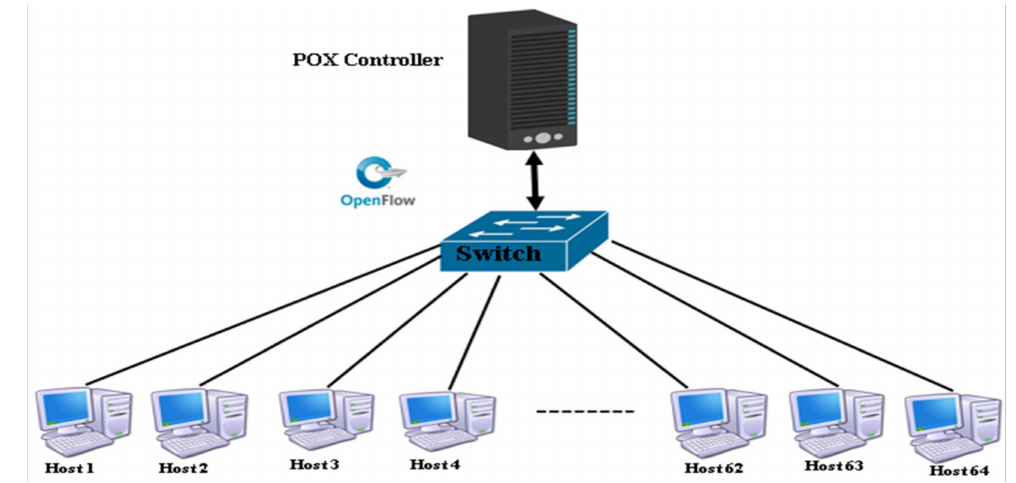
Figure 2. Experimental network